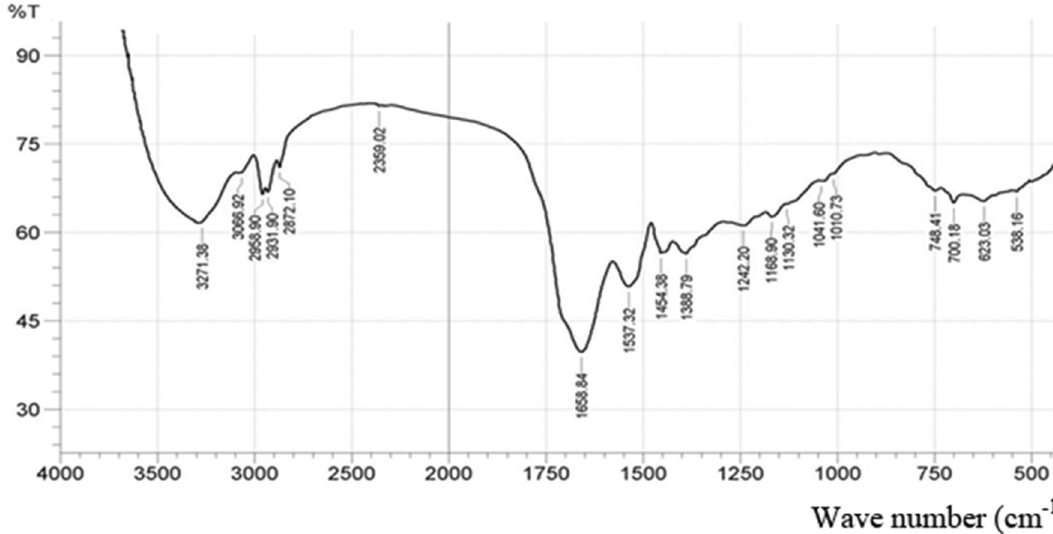
Fig. 4 FTIR spectrum of MSC after adsorption of CR